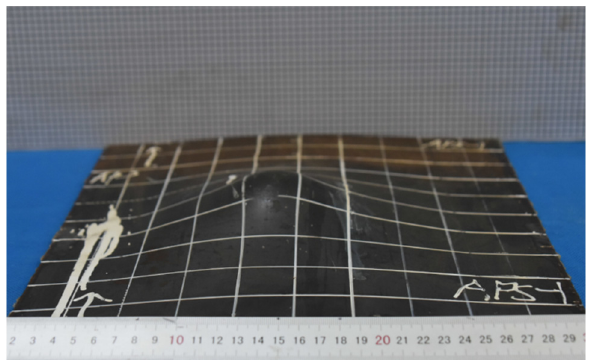
Figure 13. Bulging-dishing deformation.